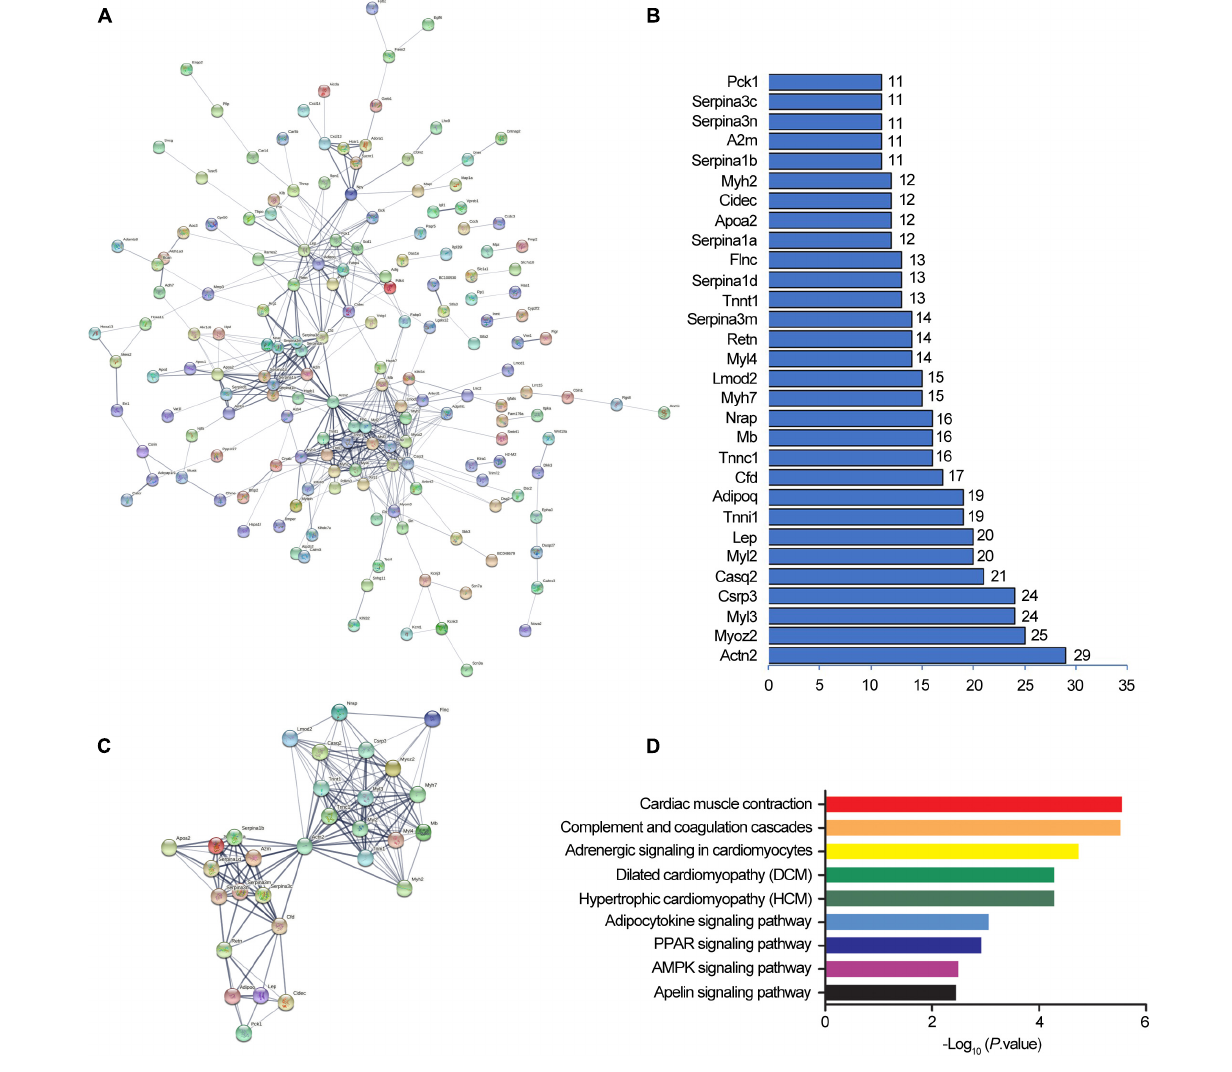
FIGURE 5 | Protein-protein interaction networks by Search Tool for the Retrieval of Interacting Genes/Proteins (STRING). STRING software constructed the differentially expressed mRNAs (fold change ≥ 2, and P < 0.05) network based on protein-protein interactions (A) . A confidence score that calculated for all protein interactions based on experimentally and computationally interaction was set as the medium ( > 0.4). Thirty top k-score genes involved in the network (B) . Thirty top k-score genes constitute the subnetworks (C) . KEGG pathway annotations of the network (D)